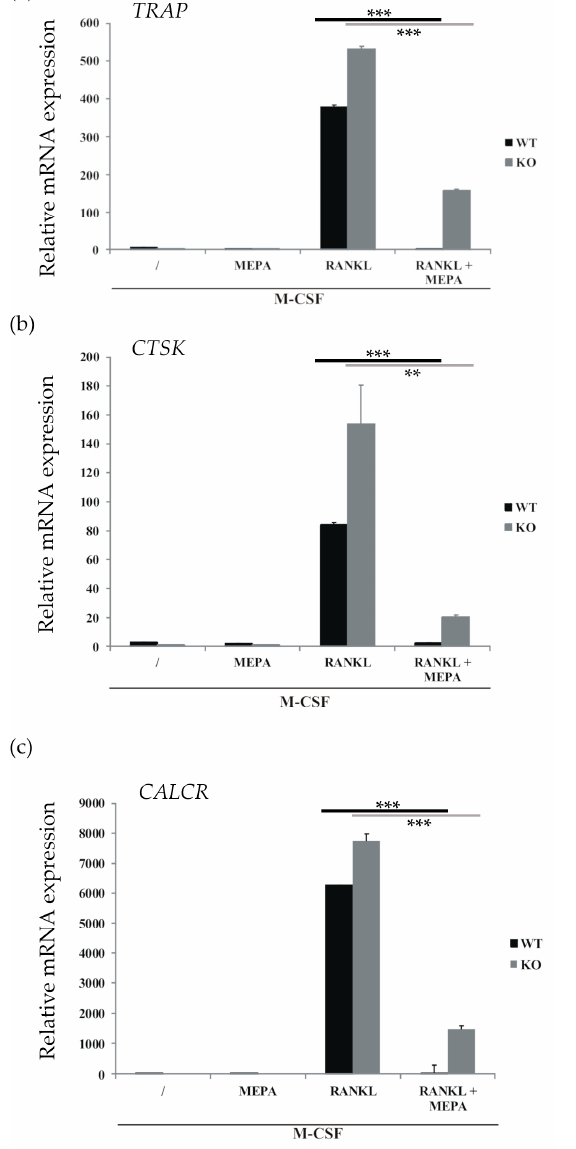
Figure 2. MALT1-independent inhibition of osteoclast-specific gene induction by mepazine. BMCs isolated from Malt1 wild-type (WT) and Malt1 knock-out (KO) mice were differentiated into osteoclasts by treatment with M-CSF (20 ng/mL), as well as RANKL (50 ng/mL) in the presence or absence of mepazine (MEPA, 13 µ M) every two days. Samples without mepazine were treated with an equal volume (0.1% final concentration) DMSO as solvent control. The / symbol represents that no RANKL or mepazine was added. mRNA was extracted at day 9 and qPCR was performed for ( a ) TRAP , ( b ) CTSK (Cathepsin K) and ( c ) CALCR (Calcitonin receptor). Values are the mean of technical triplicates ± S.D. Data are representative of two independent experiments. Statistical differences were determined by Student’s t -test, ** represents p ≤ 0.01 and *** represents p ≤